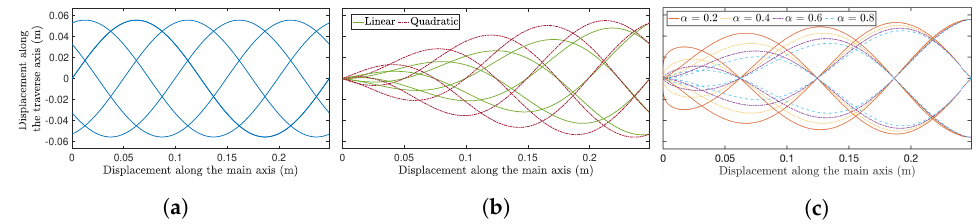
Figure 2. Appearance of the four different kinds of planar traveling waves: ( a ) harmonic waveform, ( b ) linear and quadratic Carangiform waveforms, ( c ) waveform with fractional